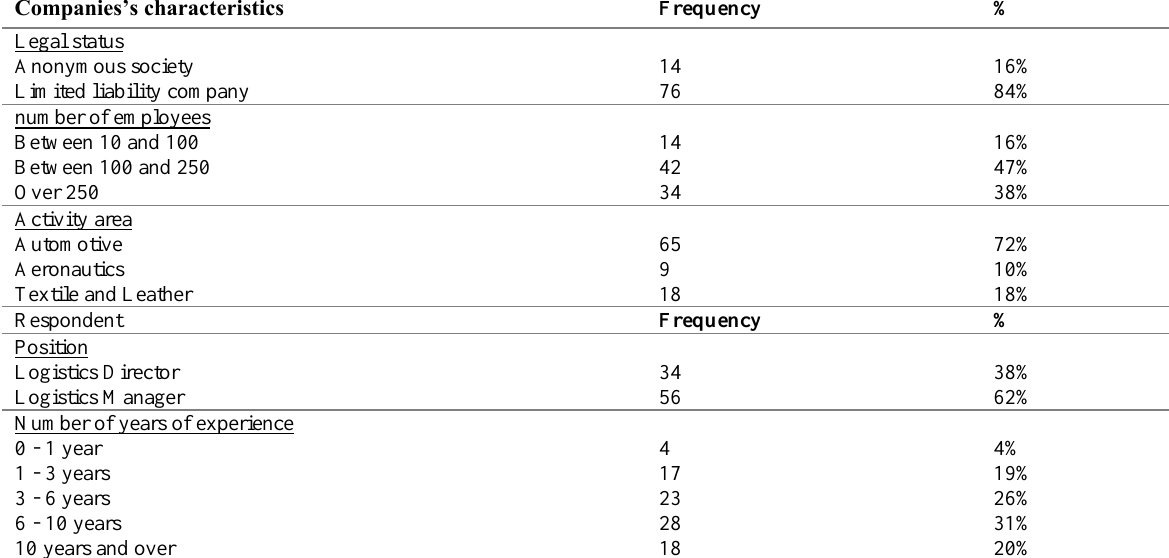
Table 2: Companies’s and respondent’s characteristics